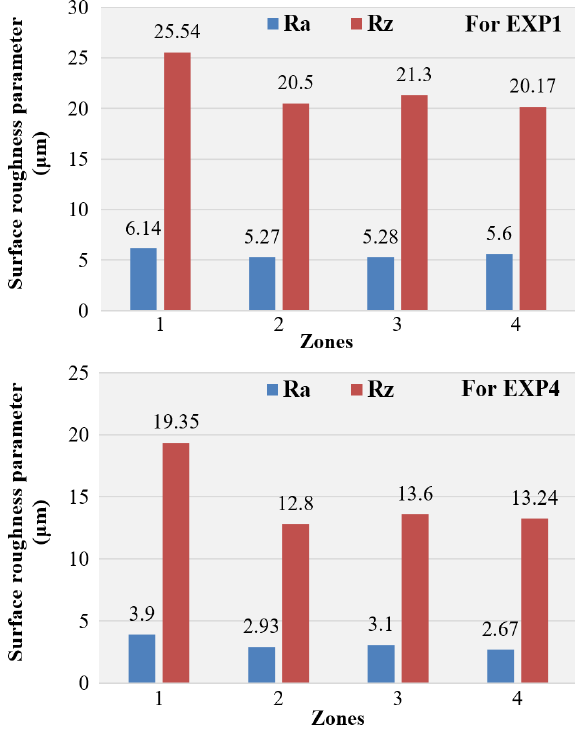
Figure 11. Measured values of parameters Ra and Rz for different machining strategies in the second